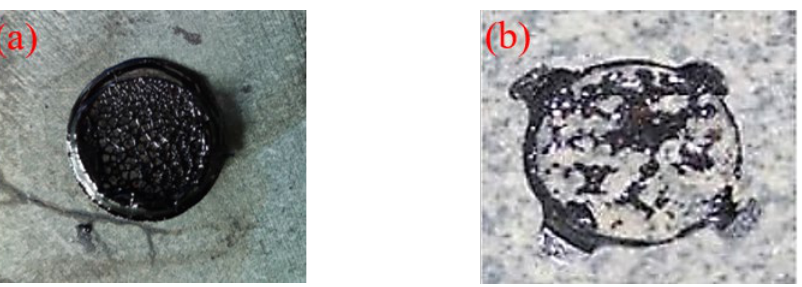
Figure 11. Examples of Bond strength Testing Failure Modes for bitumen-aggregate system: ( a ) Fail- ure within the binder, ( b ) Failure at the binder/substrate interface.